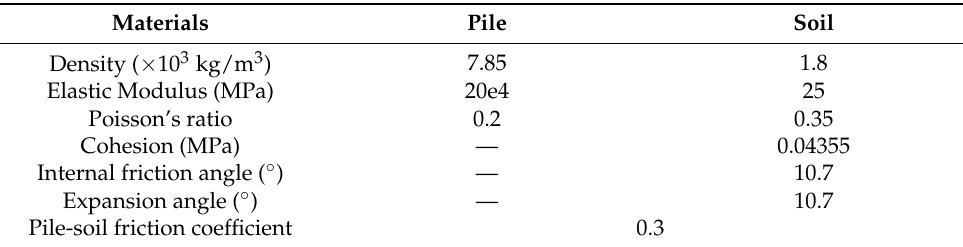
Table 3. The parameters of pile and soil in the numerical simulation.